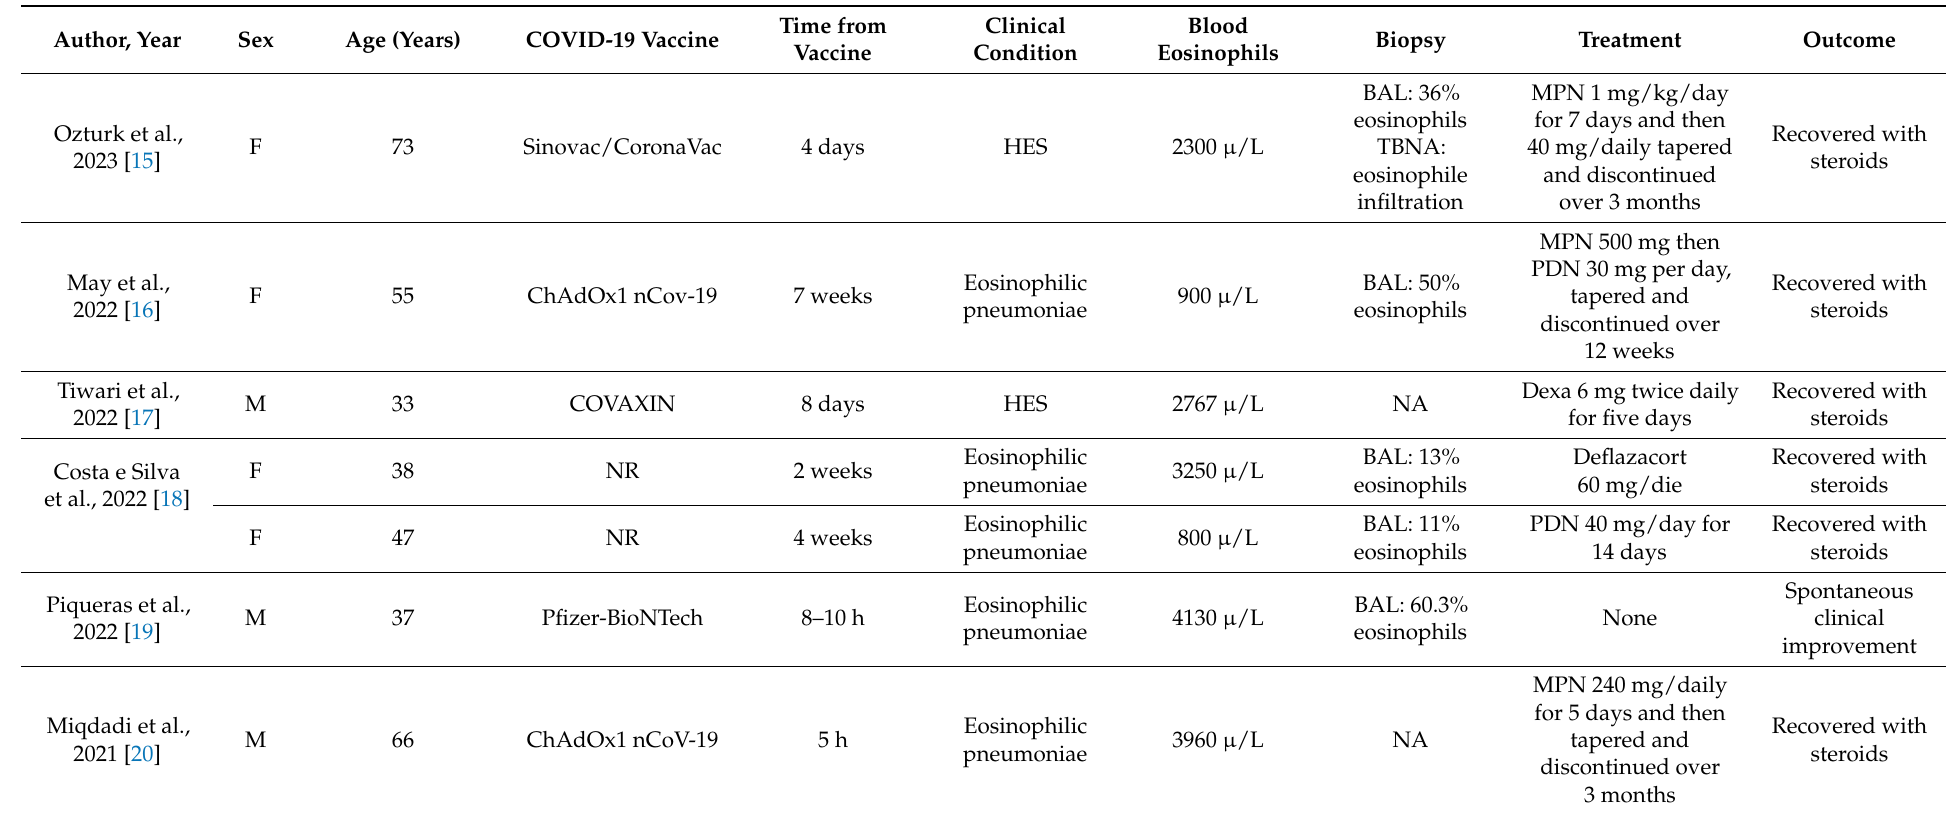
Table 1. Summary of hypereosinophilic syndrome after COVID-19 vaccine in the